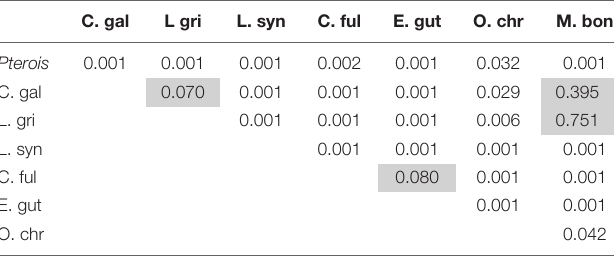
TABLE 1 | Results of Hotelling’s T 2 test comparing niche position between competitors.